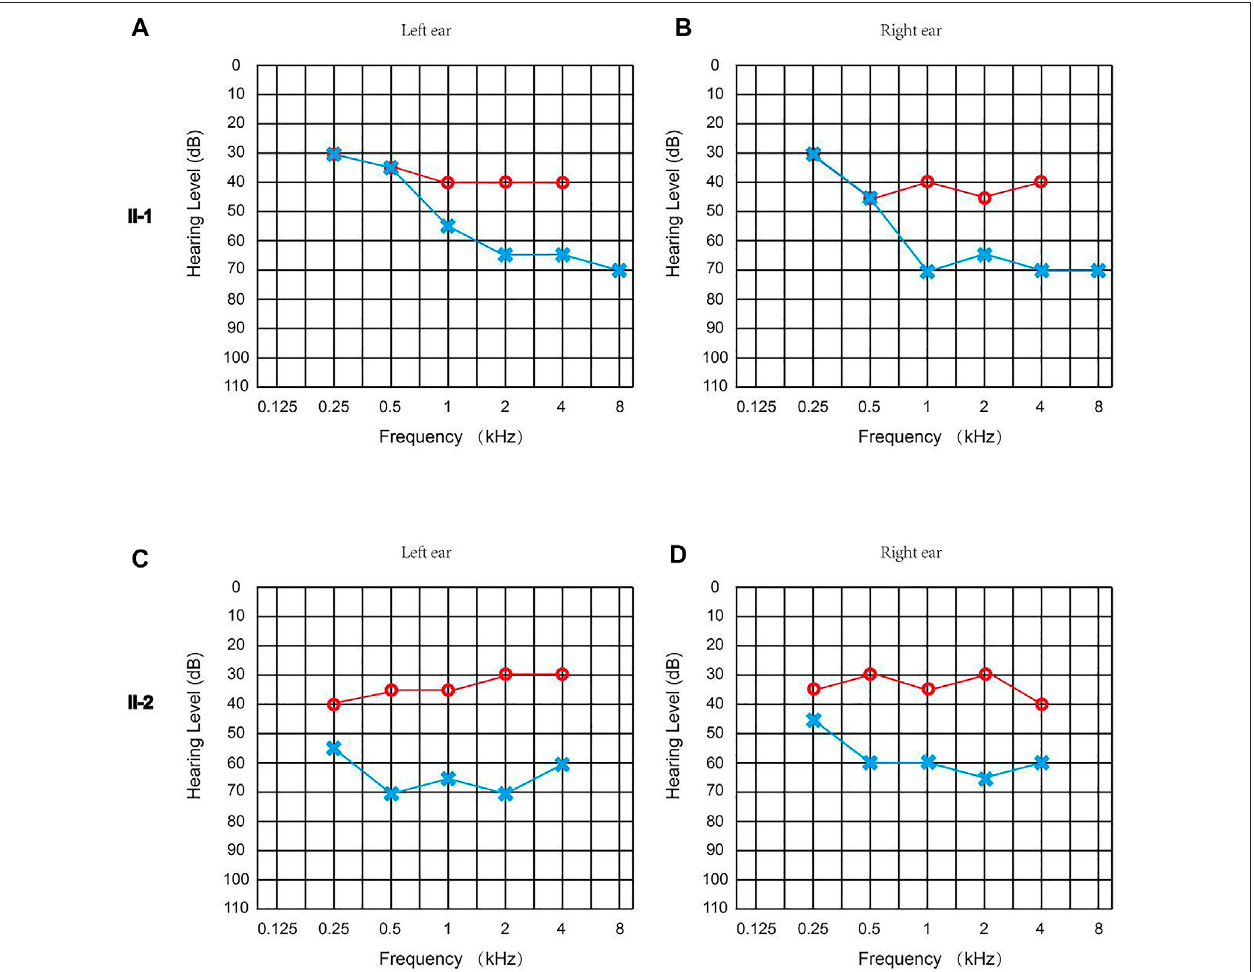
FIGURE 2 | Clinical audiology examination of the probands. (A) ASSR of Proband II-1 (left ear): 30, 35, 55, 65, 65, and 70 dBnHL at 0.25, 0.5, 1, 2, 4, and 8 kHz. (B) ASSRofProbandII-1 (rightear): 30,45,70,65,70, and 70 dBnHL at0.25, 0.5, 1,2, 4,and 8 kHz. (C) ASSRofProband II-2 (left ear): 55,70, 65,70,and 60 dBnHL at0.25,0.5,1,2,and4 kHz. (D) ASSRoftheProbandII-2(rightear):45,60,60,65,and60 dBnHLat0.25,0.5,1,2,and4 kHz.Thehearingthreshold oftwoprobands with a hearing aid is marked in red, and the hearing threshold of two probands without a hearing aid is marked in